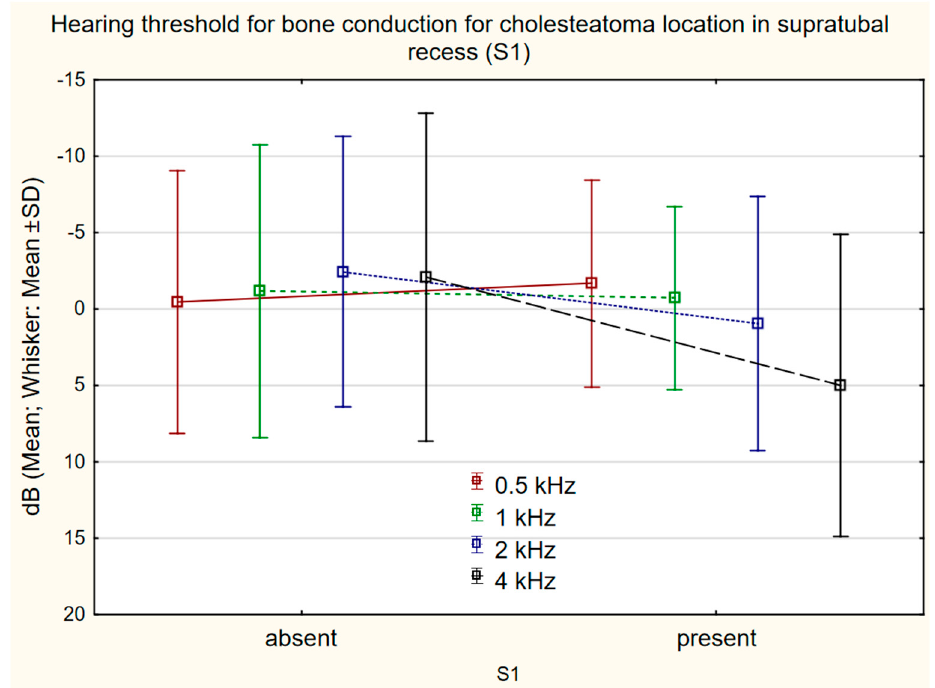
Figure 5. The difference in bone conduction prior to surgery and 1 year after surgery in presence ( n = 21) or absence ( n = 99) of cholesteatoma in the supratubal recess (S1) 4 kHz 5.00 dB (SD 9.87)/2.07 (SD 10.71) p = 0.003). Table 3. The relationship between cholesteatoma location according to STAM and the frequency of bone conduction shifts. Test ANOVA, n = 120. For the occurrence of cholesteatoma in the attic (A), a statistically significant difference at 4 kHz ( p < 0.001) was found, in the supratubal recess (S1) at 4 kHz ( p = 0.003), and for the mastoid (M) at 0.5 kHz ( p = 0.024), at 1 kHz ( p = 0.032), and 2 kHz ( p = 0.039).